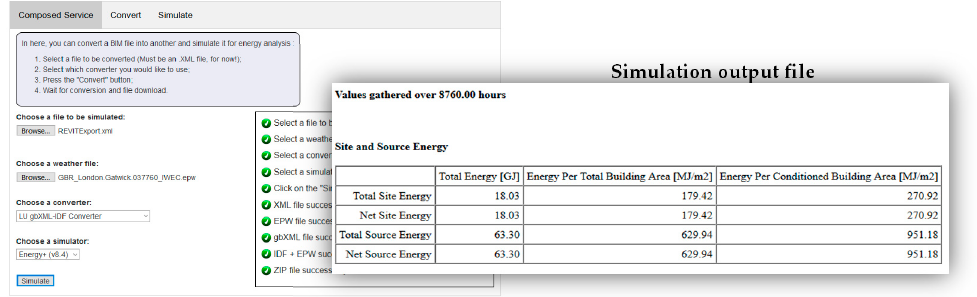
Figure 2. IS: Composed Service: from data conversion to energy